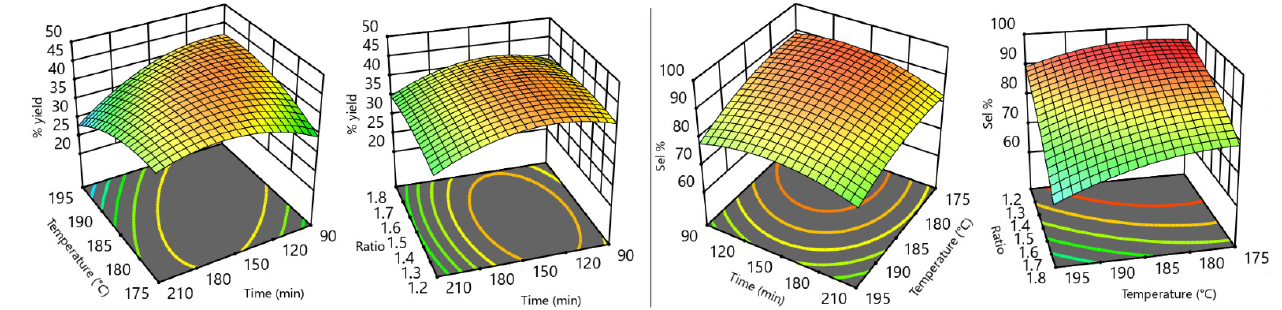
Figure 4. Two factors response surfaces.